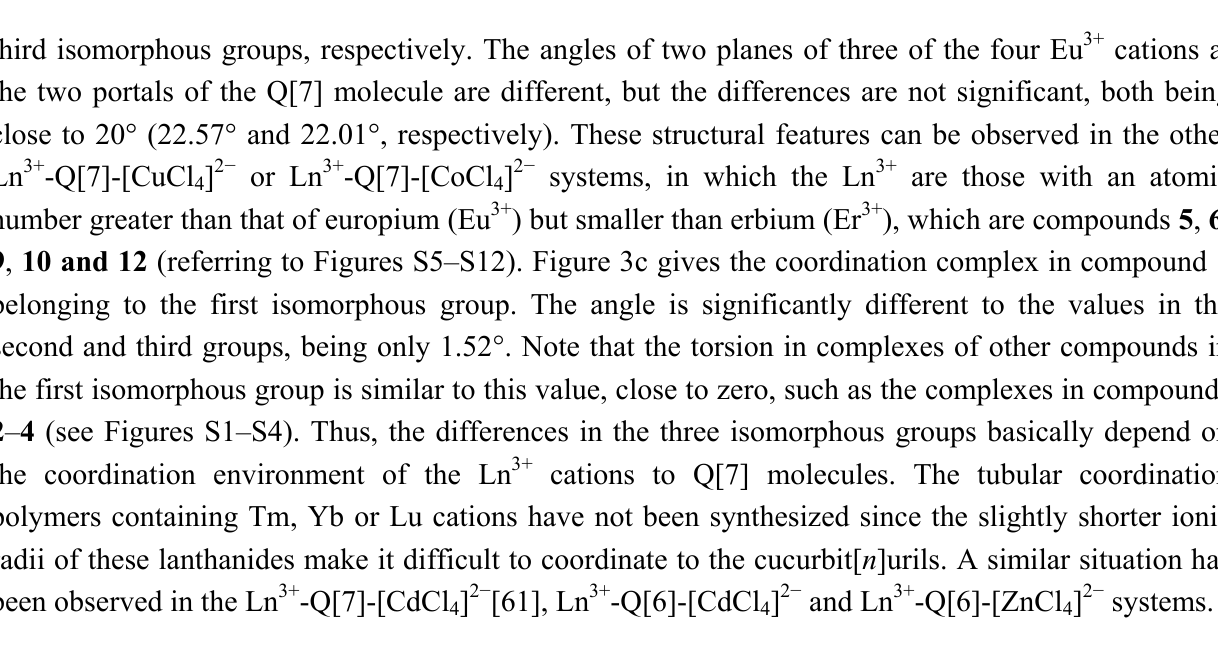
Figure 3. X-ray crystal structure of compounds 5 and 9 : ( a ) and ( b ) torsions of the four Eu 3+ cations at the two portals of a Q[7] molecule in compounds 5 and 9 , respectively; ( c ) torsion of the four La 3+ cations at the two portals of a Q[7] molecule in compound 1 for